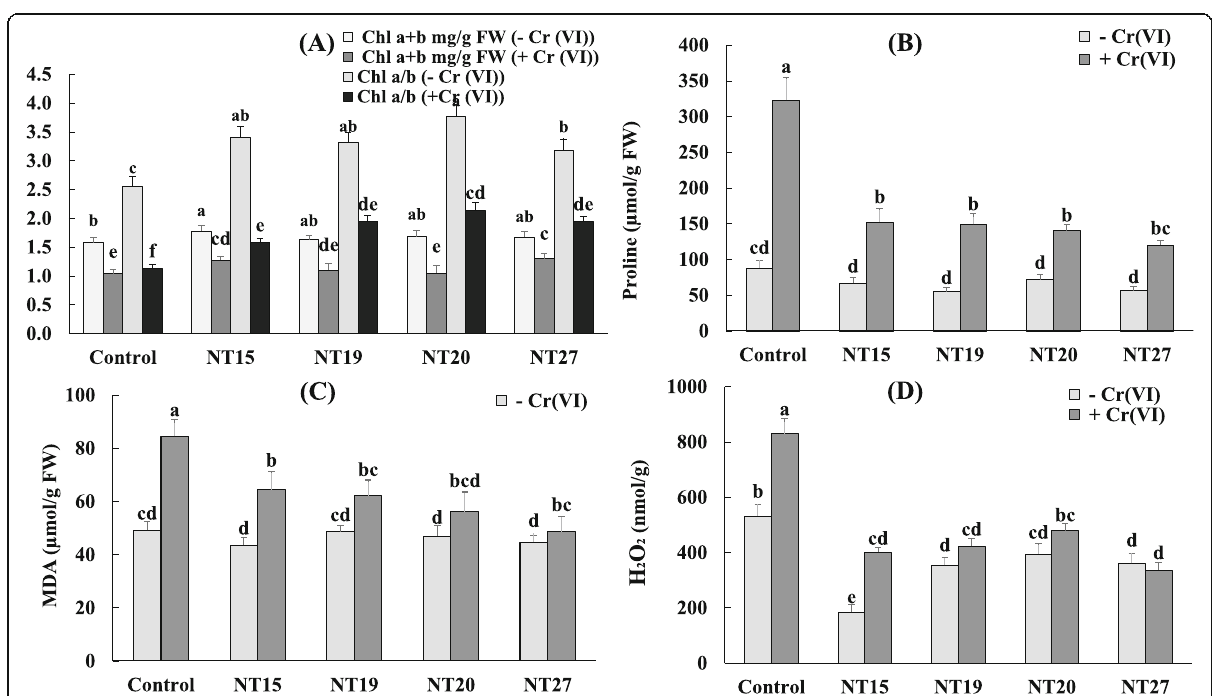
Fig. 2 Effect of bacterial inoculation on chlorophyll ( A ), proline ( B ), MDA ( C ), and H 2 O 2 ( D ) content of M. sativa leaves, in the absence ( − Cr (VI)) and in the presence of (+Cr (VI)). Values are means ± SD ; values with different letters are significantly different ( p < 0.05)